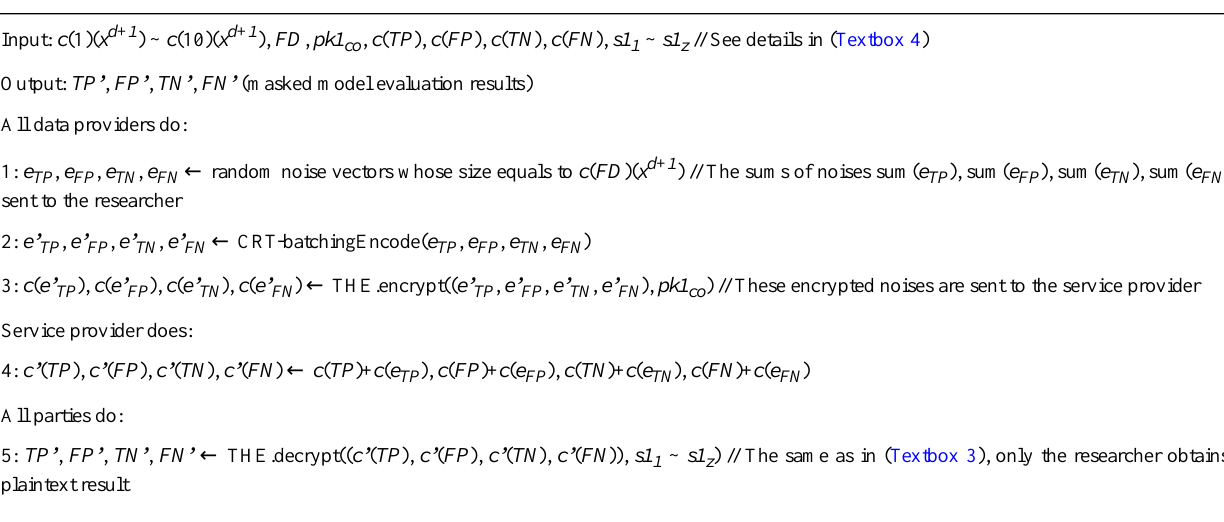
Textbox 6. Calculation of masked model evaluation results.